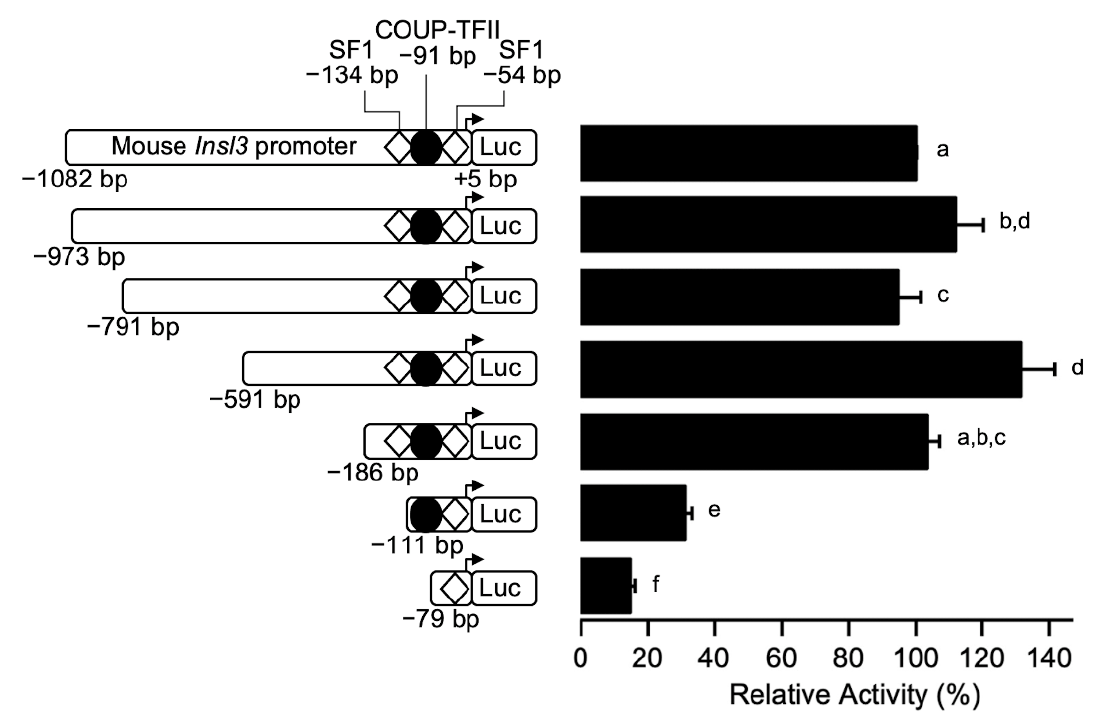
Figure 1. Identification of a critical regulatory region within the proximal mouse Insl3 promoter. MA-10 Leydig cells were transfected with various 5’ deletion constructs of the mouse Insl3 promoter; the 5 ′ end point of each construct is indicated on the left of the graph. The position of previously identified binding sites for SF1 (white diamonds) and COUP-TFII (black circle) is indicated. Results are shown as % Relative Activity (± SEM) relative to the activity of the − 1132 bp reporter, which was set to 100%. Different letters indicate a statistically significant difference between groups ( p < 0.05).